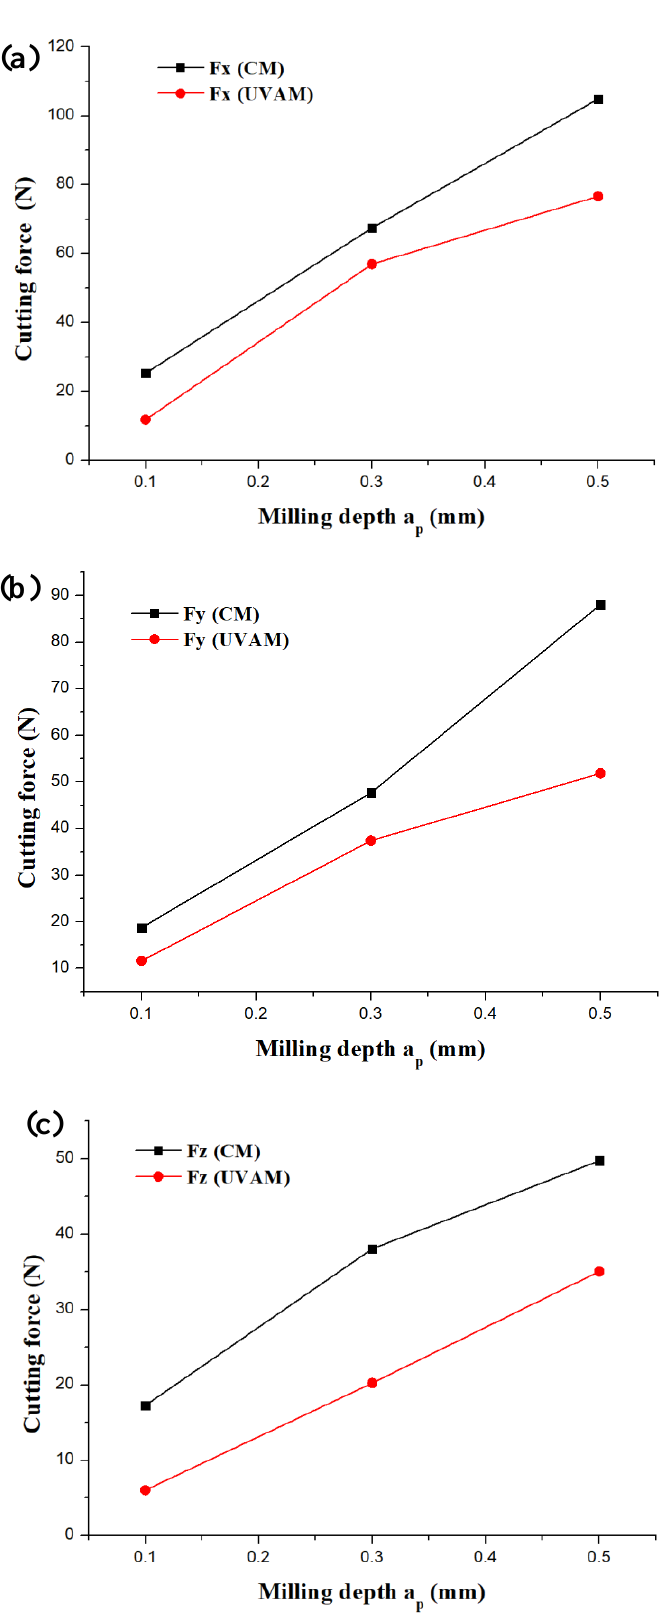
Figure 3. Influence of a p on the cutting force of CM and UVAM. ( a ) changing trend of Fx, ( b ) changing trend of Fy, ( c ) changing trend of Fz.